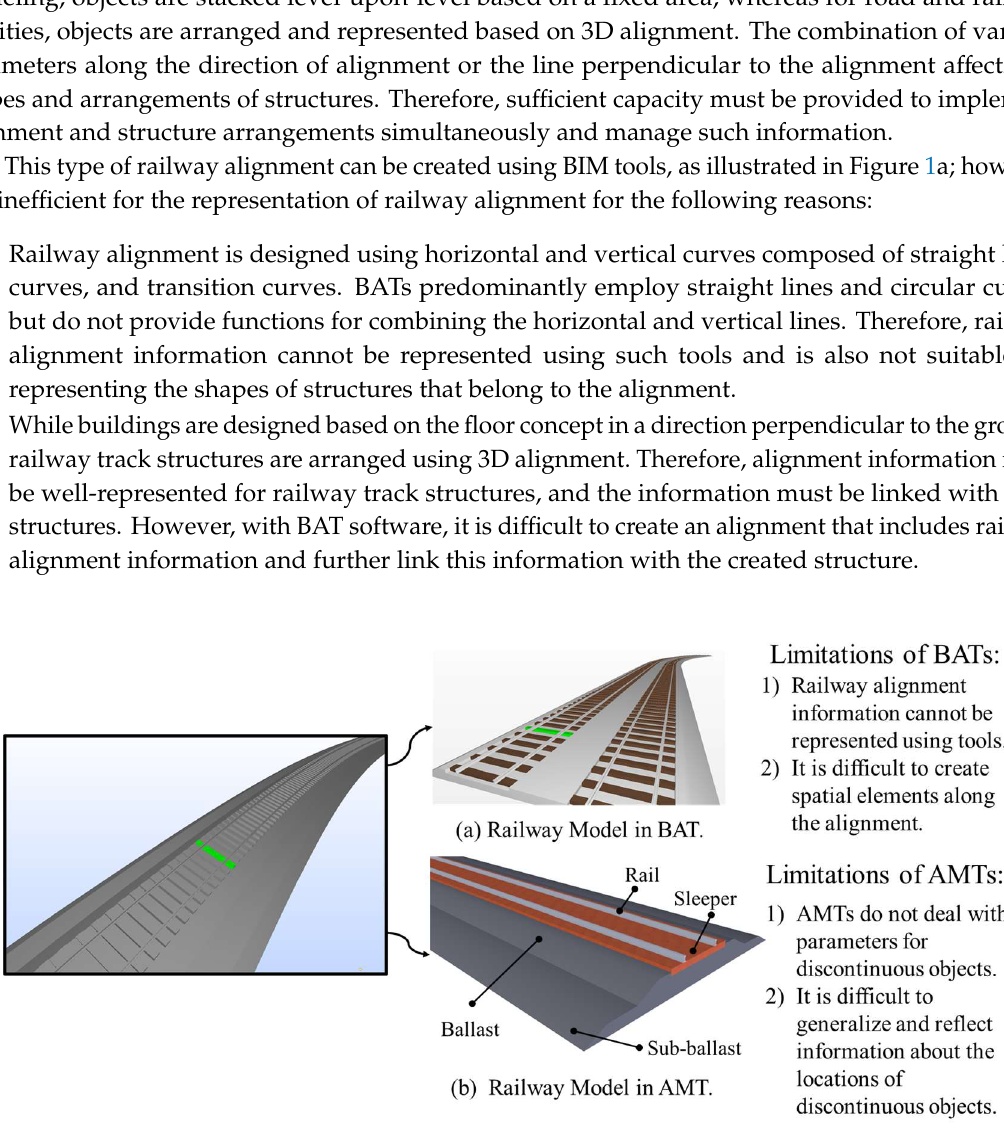
Figure 1. Software representation of railway track: ( a ) A railway model based on building information modeling authoring tools (BATs); ( b ) a railway model based on alignment-centered modeling tools (AMTs).